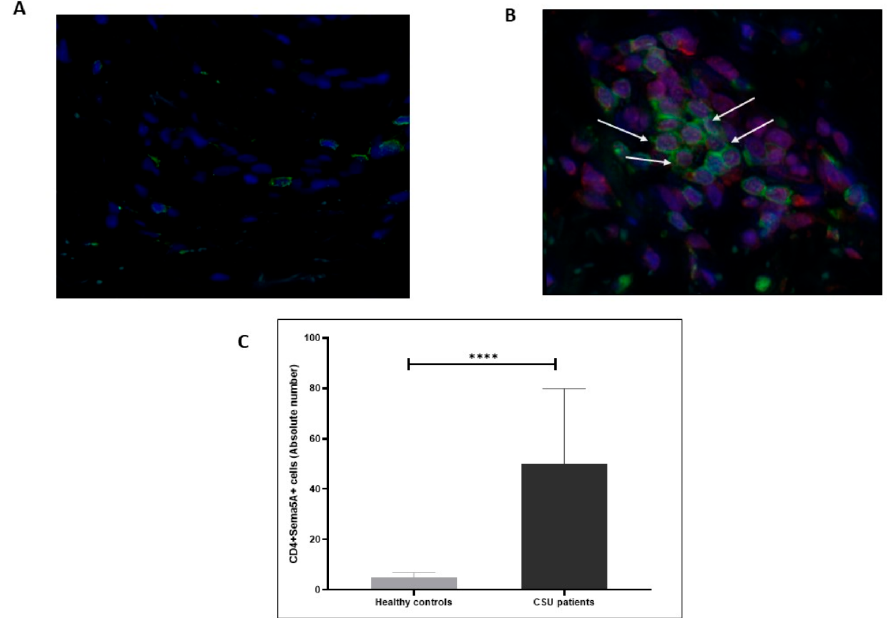
Figure 1. Semaphorin5A expression is increased in the lesional skin of patients with CSU. Almost no Sema5A expression is seen in the skin of healthy control subjects ( A ) as compared to strong expression in the skin of CSU patients ( B ). The pictures are 20X magnification. Both CD4+ T cells and mast cells (CD117+) showed the expression of Sema5A in the skin of patients with CSU and healthy control subjects. The skin of patients with CSU had 5-fold higher numbers of Sema5A-expressing CD4+ T cells and 3-fold higher numbers of Sema5A-expressing mast cells, as compared to health control skin ( p < 0.05; Figures 2 and 3).